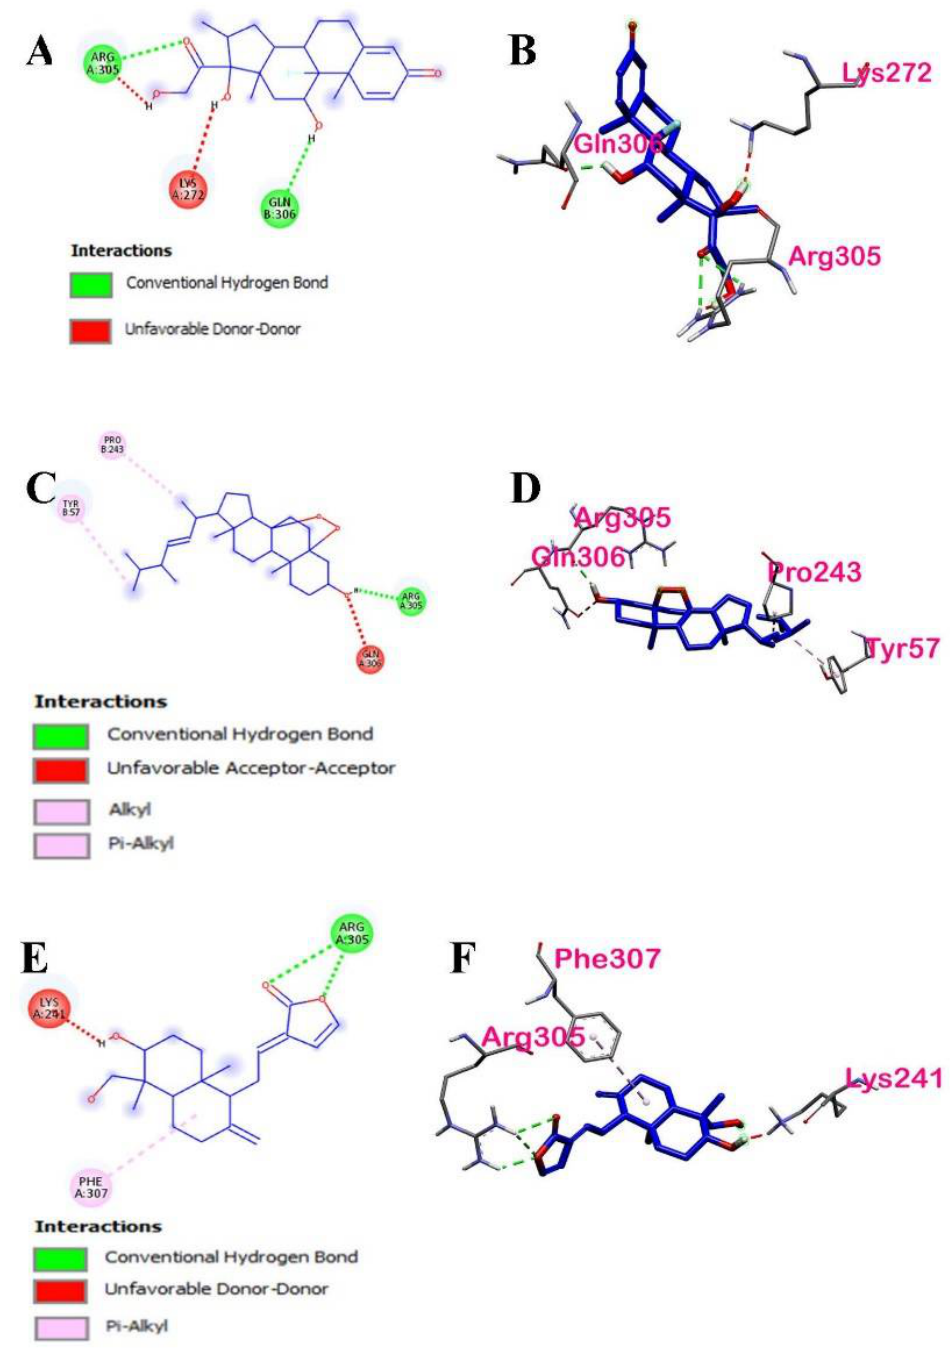
Figure 15. Two- and three-dimensional interactions of dexamethasone and ligands that have highest binding affinities with NF-κB p50: ( A ) 2D interaction of dexamethasone, ( B ) 3D interaction of dexa- methasone, ( C ) 2D interaction of ergosterol peroxide, ( D ) 3D interaction of ergosterol peroxide, ( E ) 2D interaction of 14-deoxy-14,15-dehydroandrographolide, and ( F ) 3D interaction of 14-deoxy-